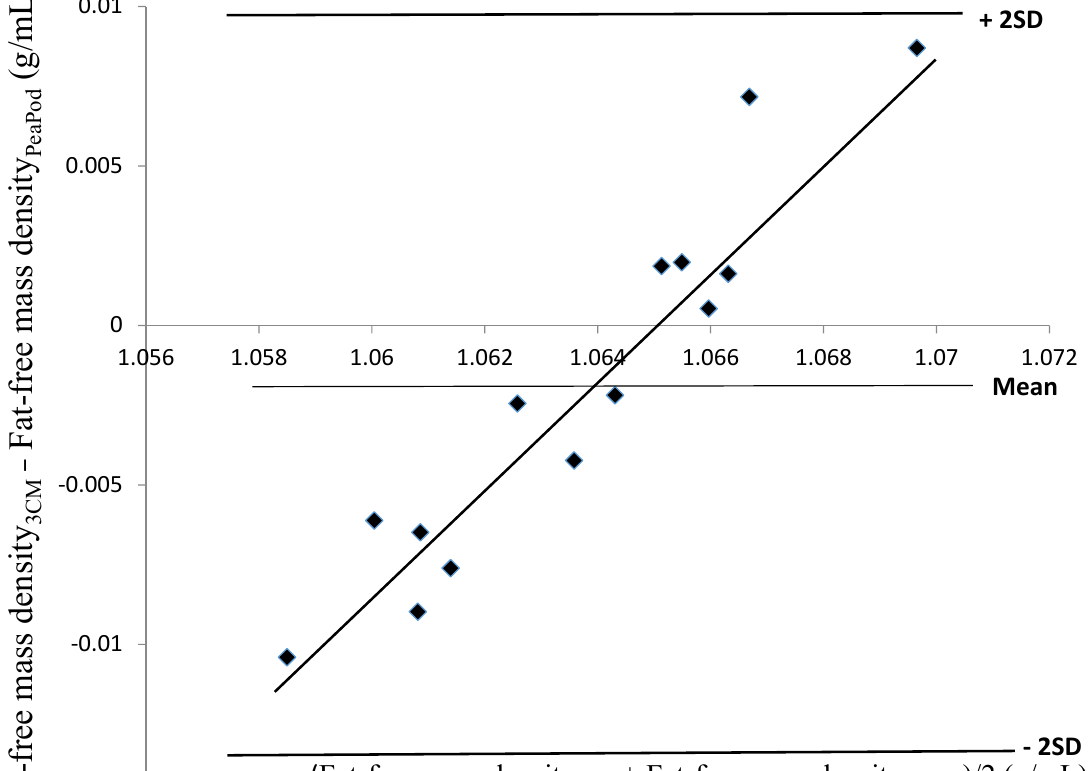
Figure 1. The difference between fat ‐ free mass density (g/mL), assessed by means of the three ‐ component model (Fat ‐ free mass density 3CM ) and the corresponding values predicted by the Pea Pod software (Fat ‐ free mass density PeaPod ) (Fat ‐ free mass density 3CM − Fat ‐ free mass density PeaPod ) ( y ) versus the average of Fat ‐ free mass density 3CM and Fat ‐ free mass density PeaPod (Fat ‐ free mass density 3CM + Fat ‐ free mass density PeaPod )/2 ( x ). Average and ± 2SD (limits of agreement) for (Fat ‐ free mass density 3CM − Fat ‐ free mass density PeaPod ) = − 0.0019 ± 0.0117 g/mL. Regression equation: y = 1.79 x − 1.90, r 2 = 0.91 ( p < 0.001). Values are based on 14 moderately premature infants, 3–7 days old.